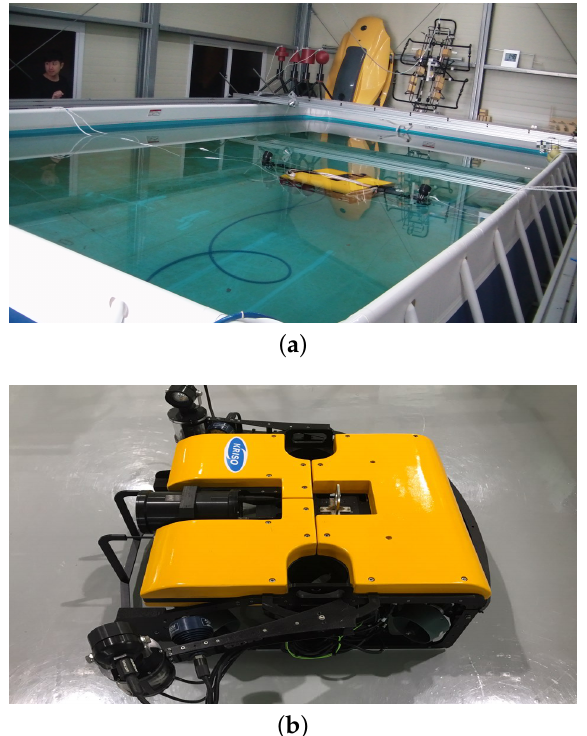
Figure 6. Test pool and UUV used in experiment 2. ( a ) test pool; ( b ) UUV.